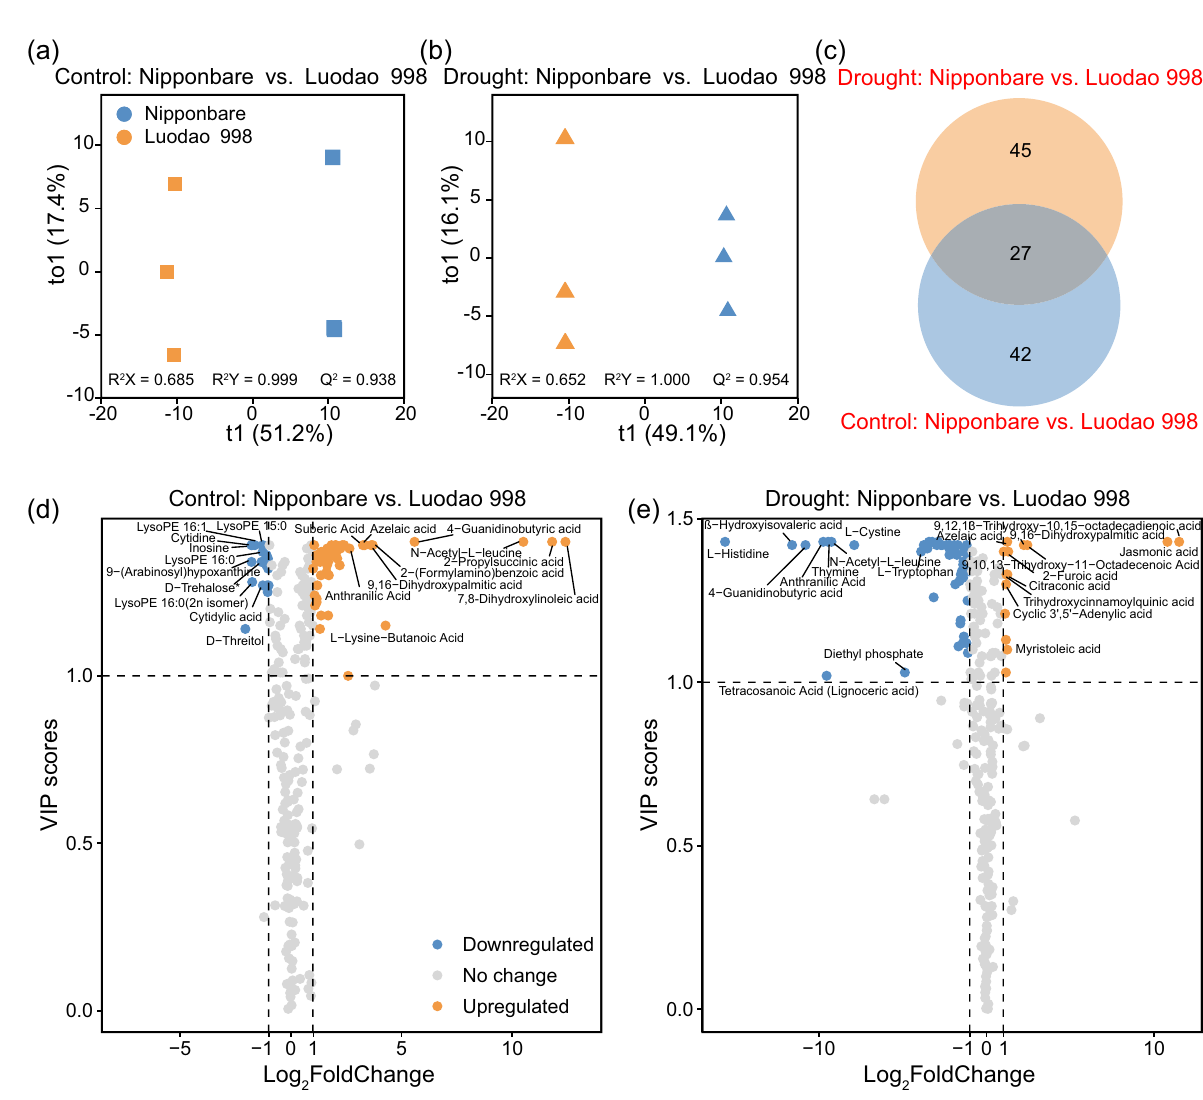
Fig. 6 Changes in root exudate composition between the two rice genotypes. Metabolomic profiles of root exudates between the two contrasting rice genotypes under a control and b drought conditions assessed by OPLS-DA. c Number of differential metabolites between the two rice genotypes under different watering treatments. Volcano plots of differential metabolites between the two distinct rice genotypes in d control and e drought groups. The top 10 differential metabolites with the largest and smallest fold changes are labelled with